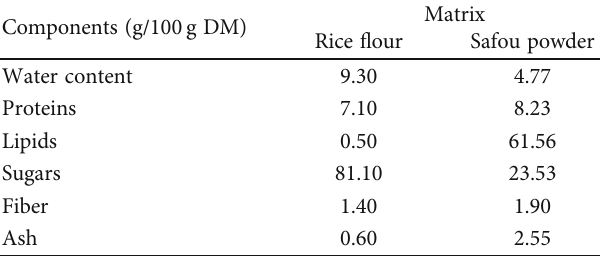
Table 1: Nutritional composition of rice fl our and safou powder